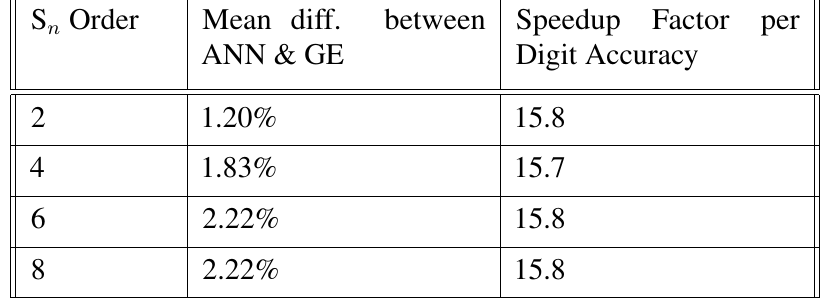
Table 3: ANN results for the Benchmark problem [6] with c = 0 .